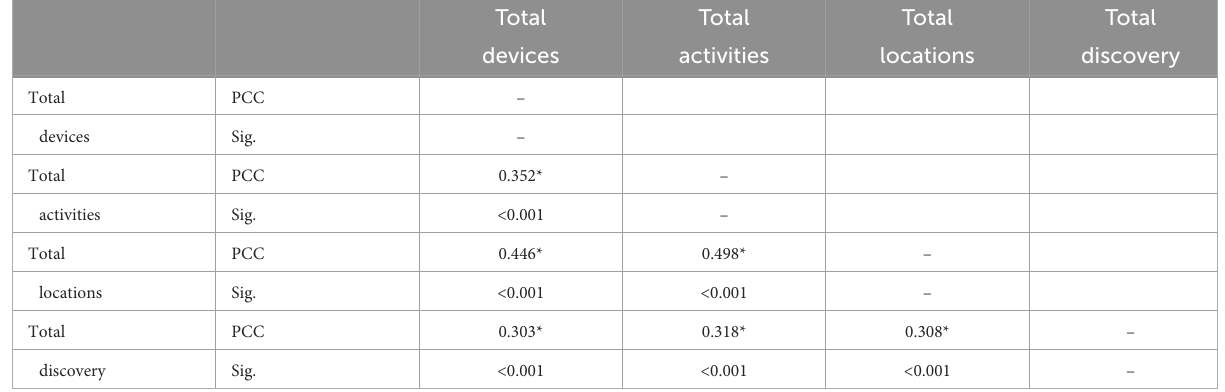
TABLE 10 Pearson’s product-moment correlations amongst the total monitoring devices, total multitasking activities, total listening locations, and total discovery methods. ( N =